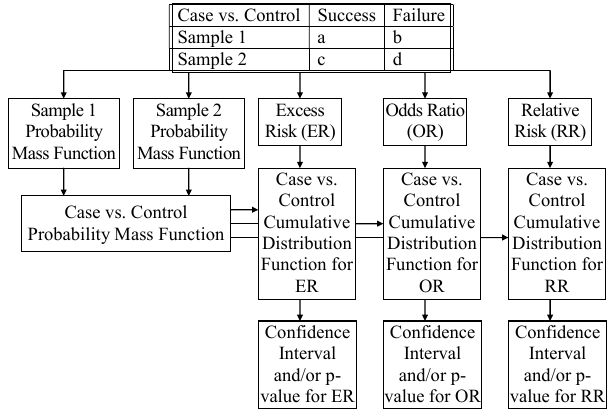
Figure 1. Research